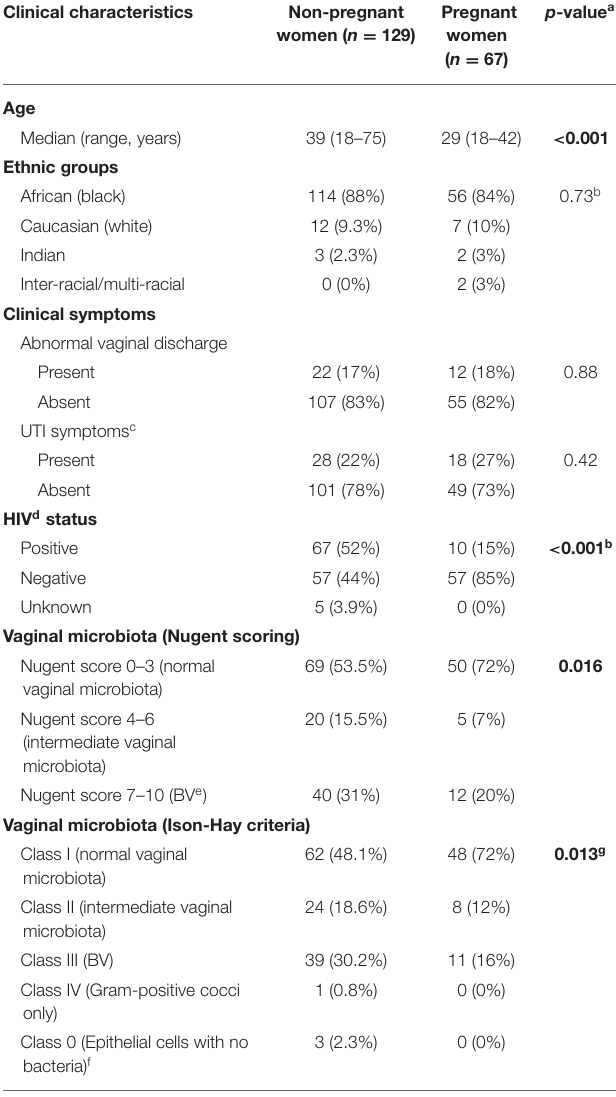
TABLE 1 | Demographic, clinical and microbiological characteristics of the women included in the study. Clinical